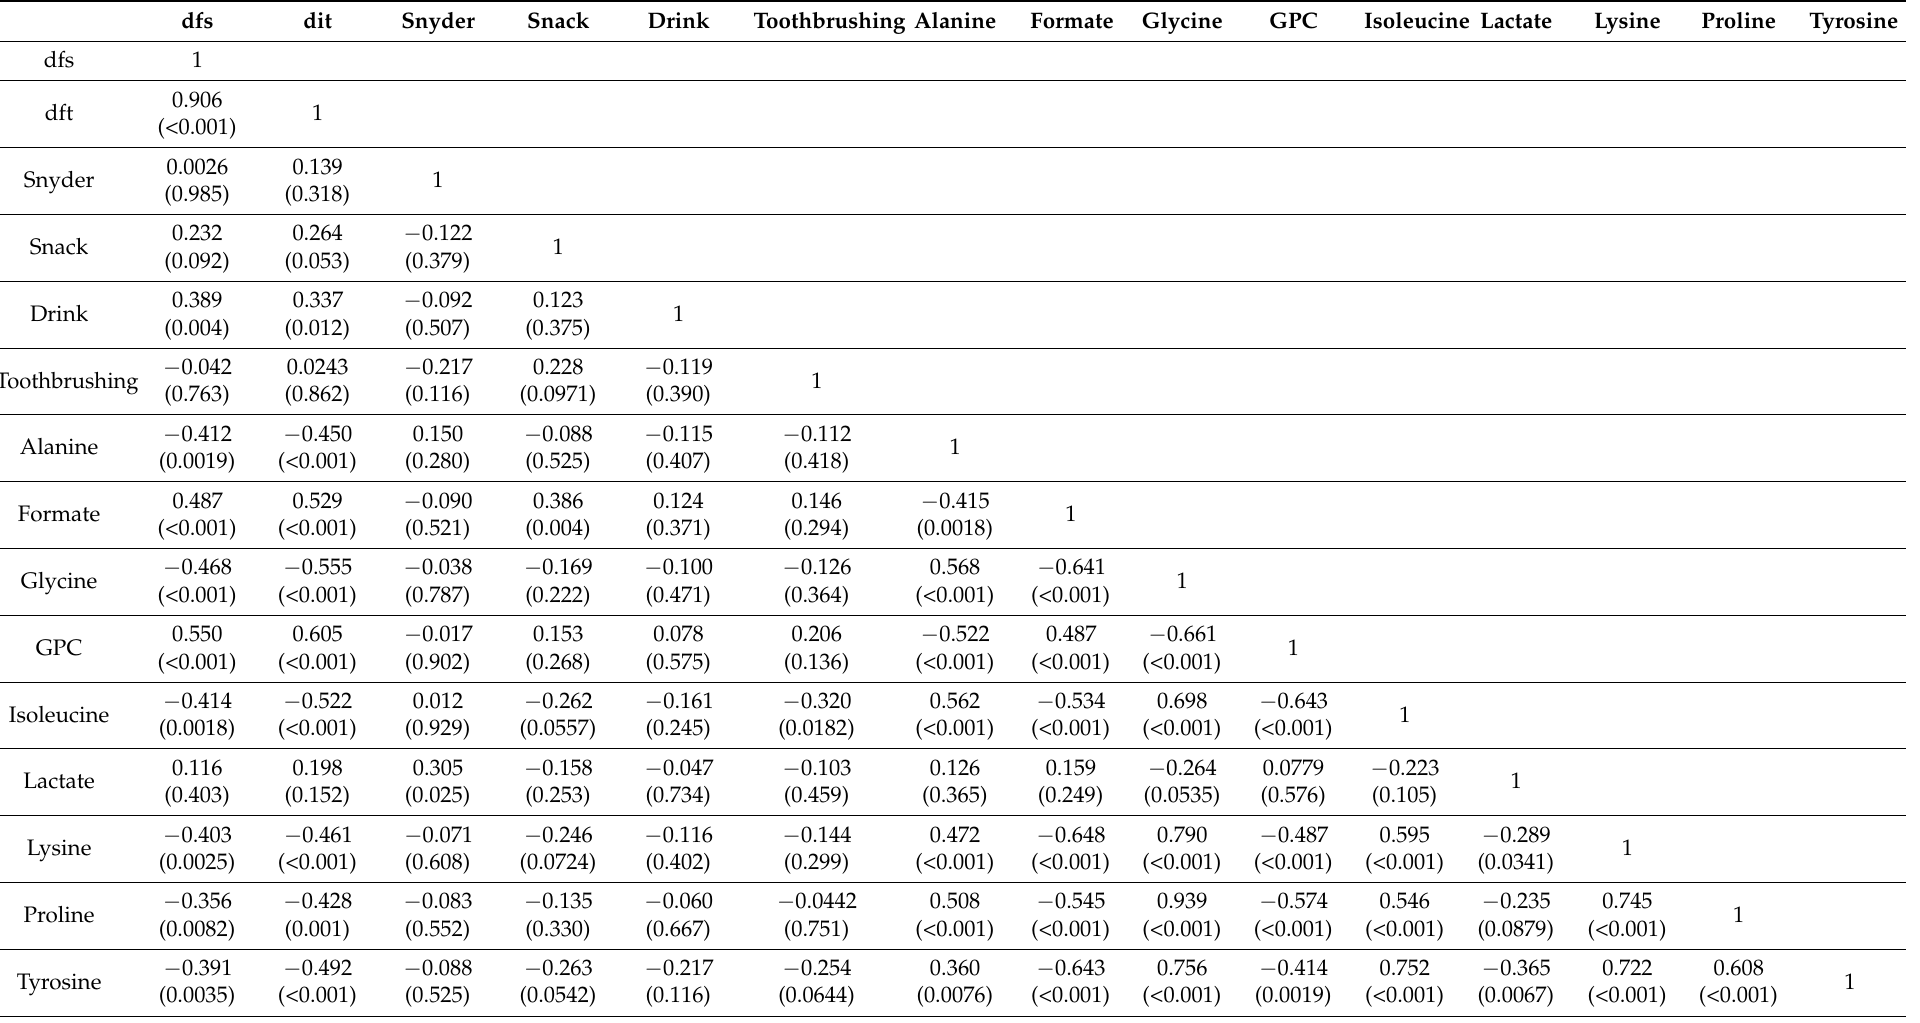
Table 3. Correlation analysis between nine potential metabolite biomarkers and clinical parameters. Pearson’s correlation coefficient (r) and the corresponding p